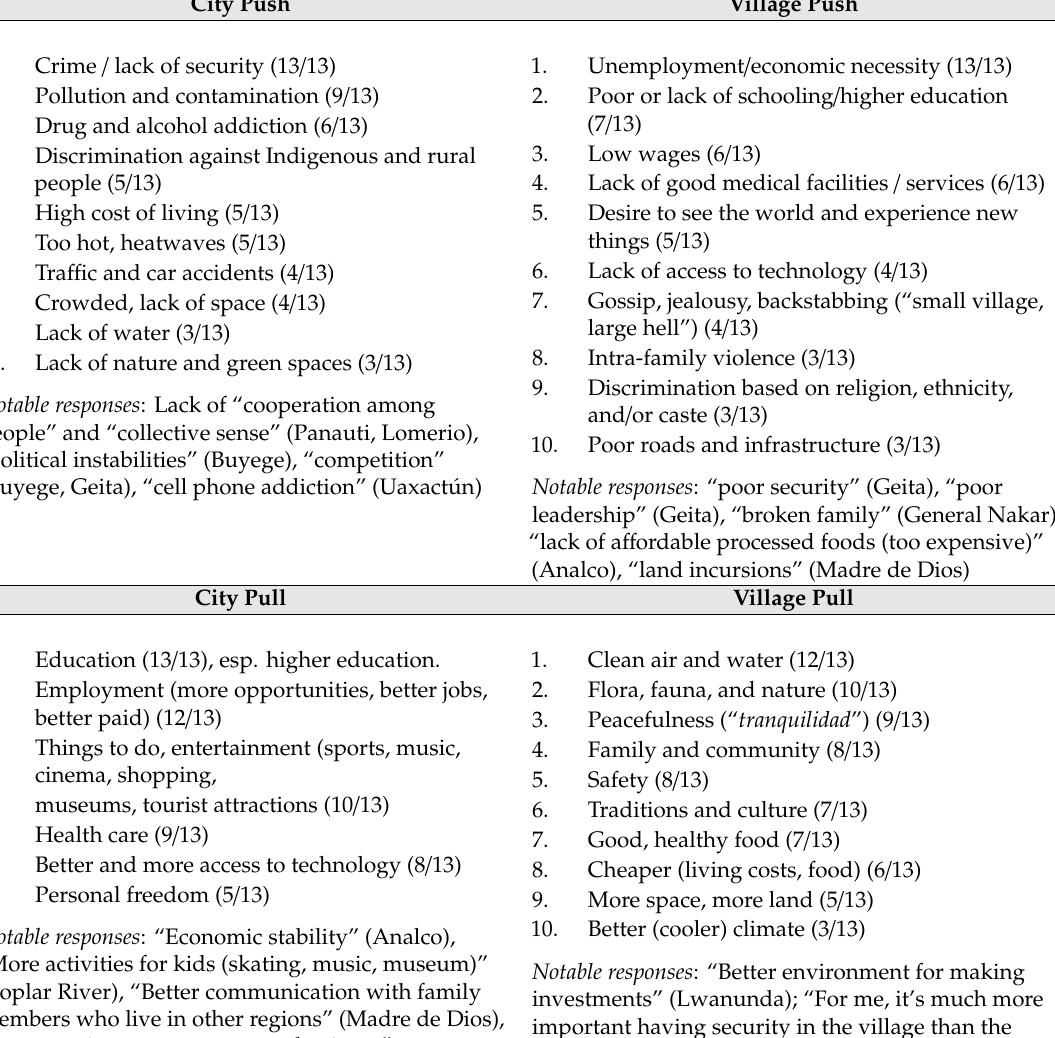
Table 2. Push–Pull Matrix (aggregate results from 13 workshops analysed). City